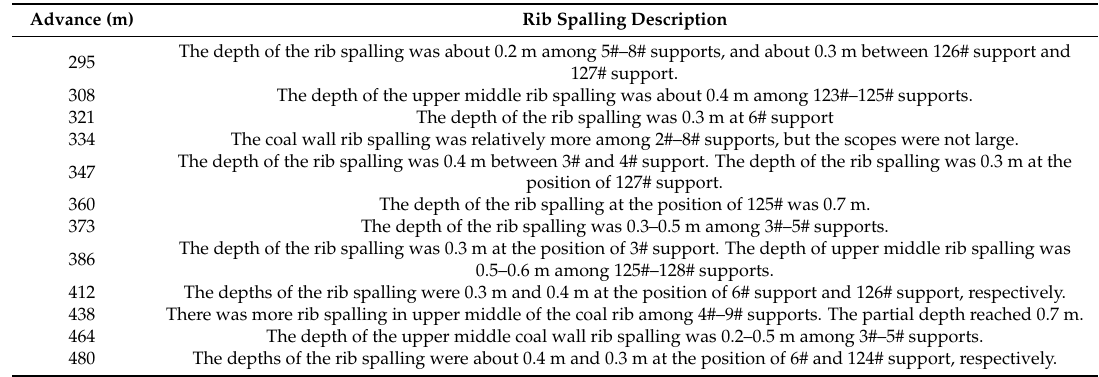
Table 5. Statistics of coal wall rib spalling after the grouting of the 5303 coal